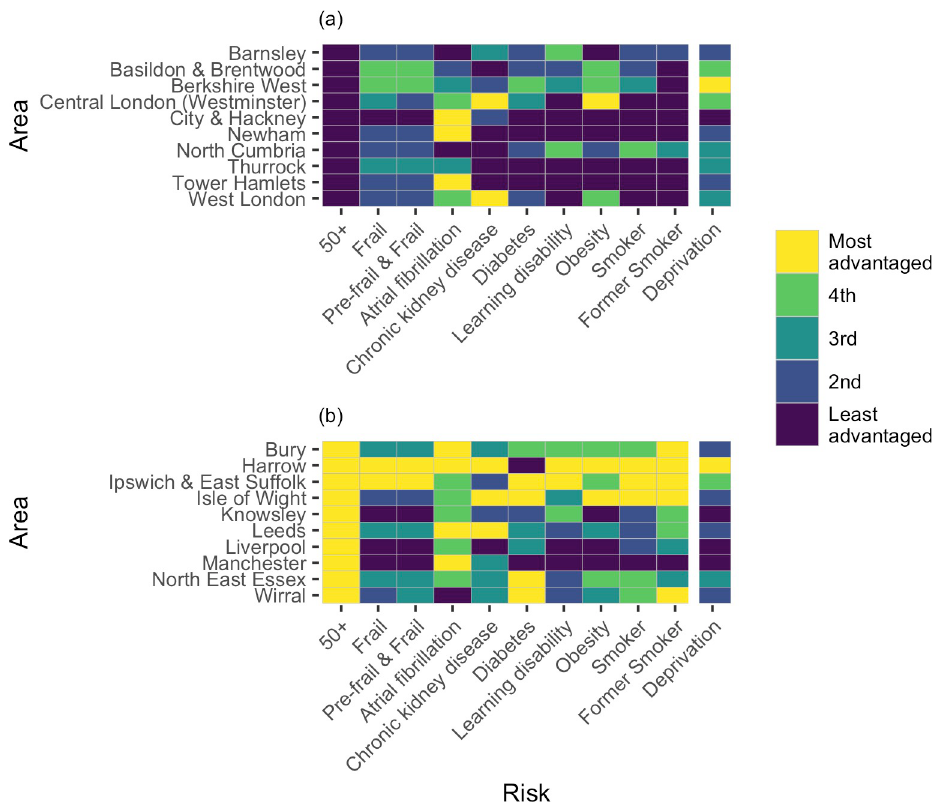
Fig 2. Heatmap of first vaccine doses administered relative to the number of people diagnosed with risk factors associated with COVID-19, for selected Clinical Commissioning Group (CCG) areas of England. The (a) bottom and (b) top ten CCG areas for the ratio of first vaccine doses to people aged over 50 are plotted. The ratio of first vaccine dose to the number of people with each of nine risk factors (by quintile), in each area, are shown. The risk factors are associated with infection, hospitalisation and mortality due to COVID-19 [18]. Area deprivation quintile (measured by English Index of Multiple Deprivation) are also shown. Quintiles indicate the most advantaged to least advantaged areas: the most advantaged areas have the most first doses per person with each risk factor and lowest area